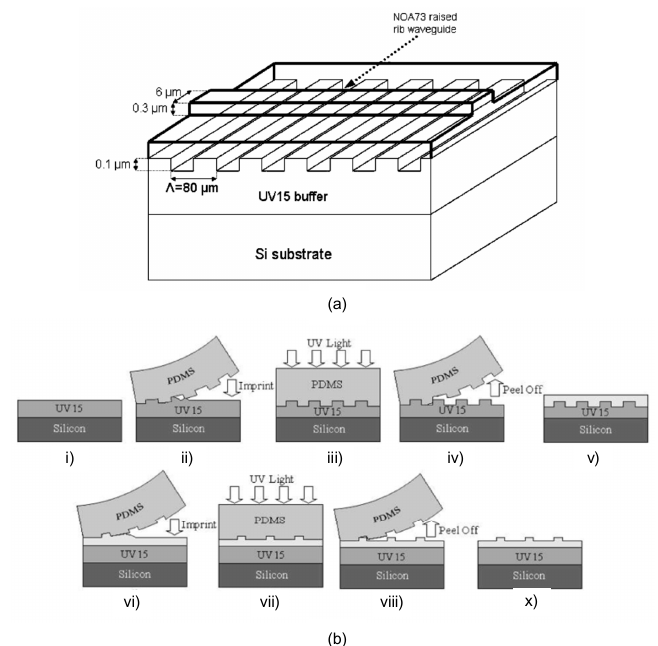
Figure 13. ( a ) Schematic structure of the LPWG; ( b ) two processes for imprinting the grating waveguides (i)–(v) and for rib waveguide (vi)–(x) [56]. Copyright 2005 IEEE.